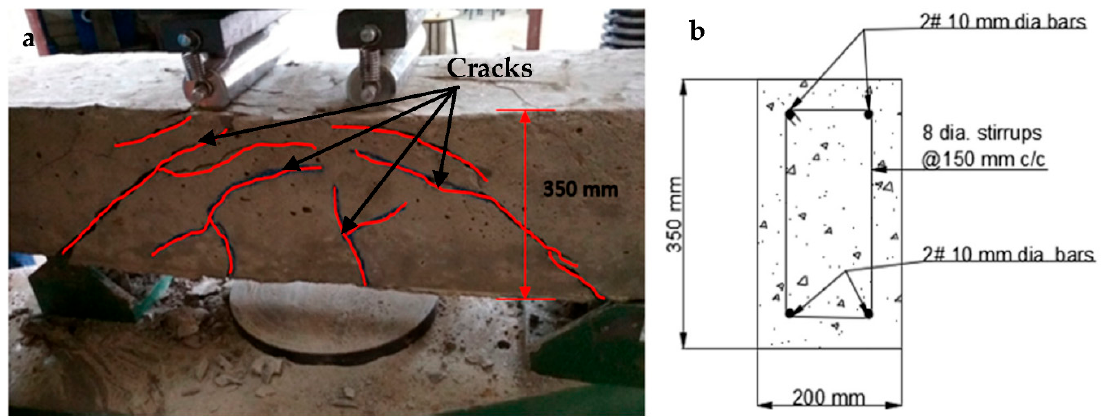
Figure 15. ( a , b ) Formation of the crack in controlled beam (CB1).